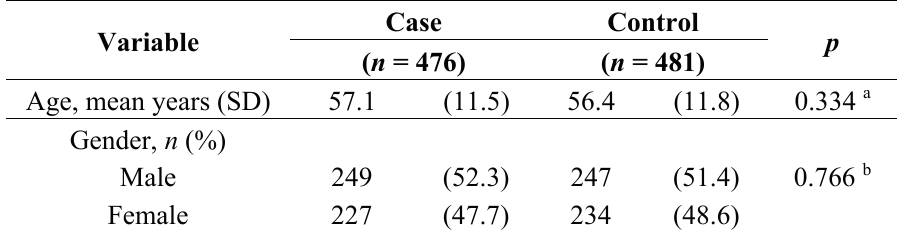
Table 2. Characteristics of cases and controls.